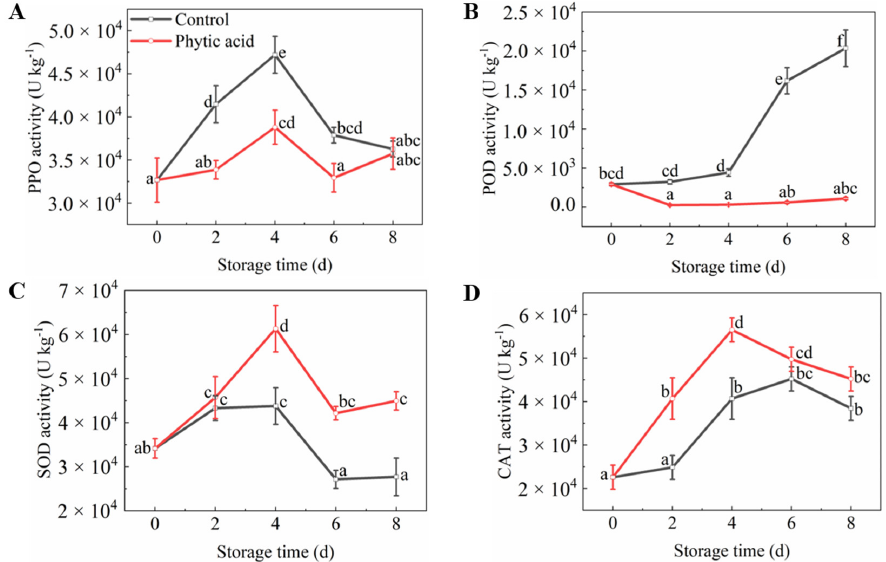
Figure 5. Browning-related enzyme activities of fresh-cut apples during storage after treatment with phytic acid or the control. ( A ) PPO activity; ( B ) POD activity; ( C ) SOD activity; ( D ) CAT activity. Vertical bars represent standard errors of the means of three replicates. The different letters indicate significant differences at p < 0.05. significant differences at p <